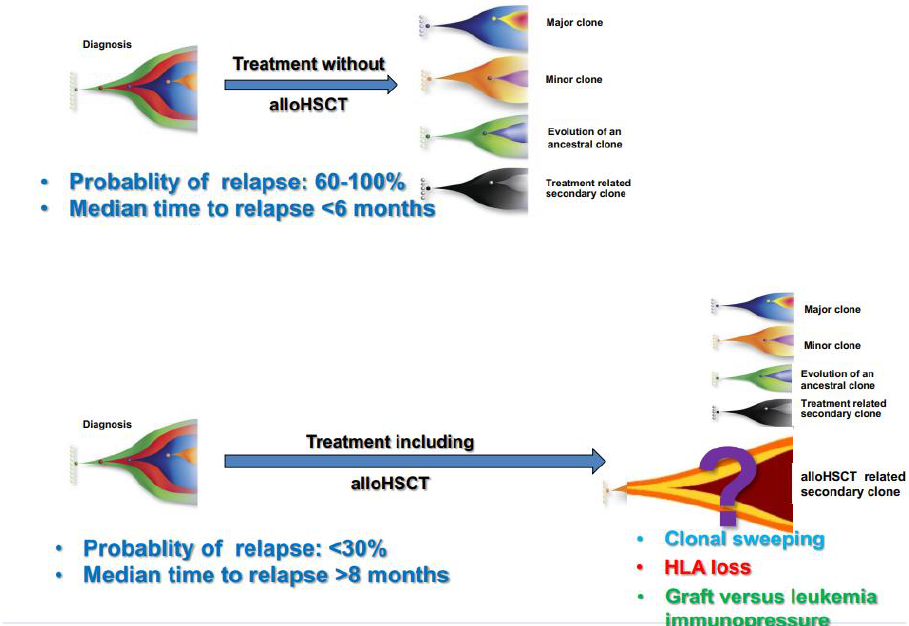
Figure 3. Clonal evolution and probability of relapse after conventional chemotherapy without transplant and after a program including transplant.